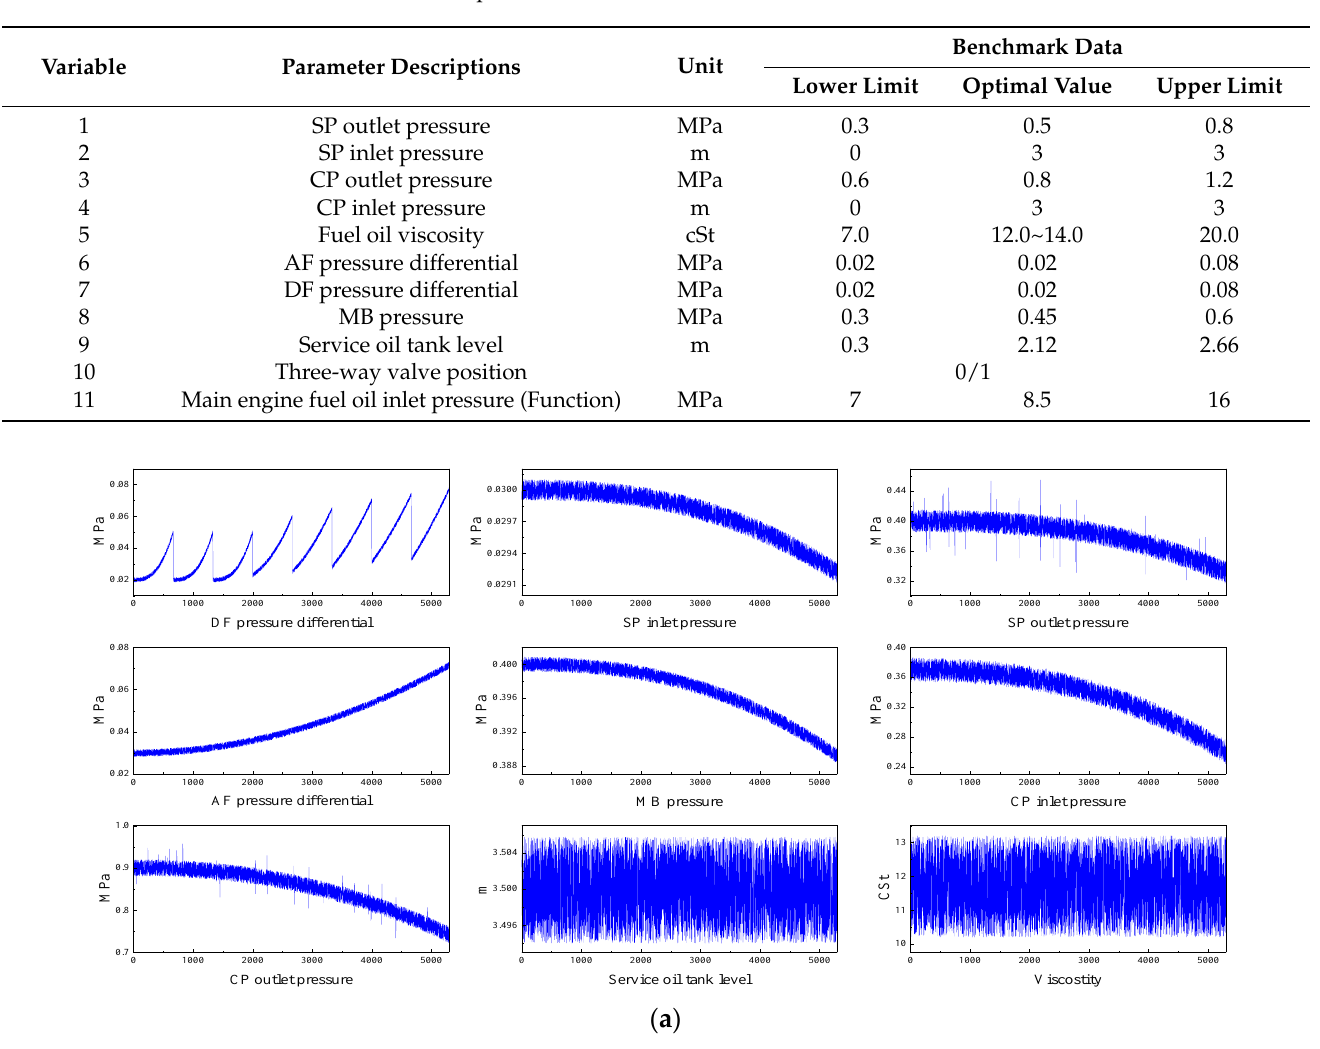
12 of 20 Table 1. Description of sensor data sets. Variable